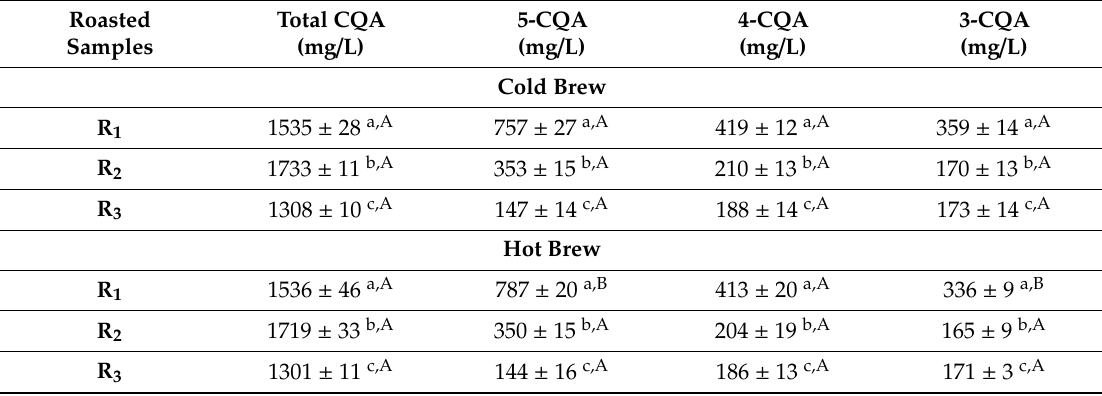
Table 2. Total CQA and CQA isomer concentration of cold and hot brew samples at di ff erent degrees of